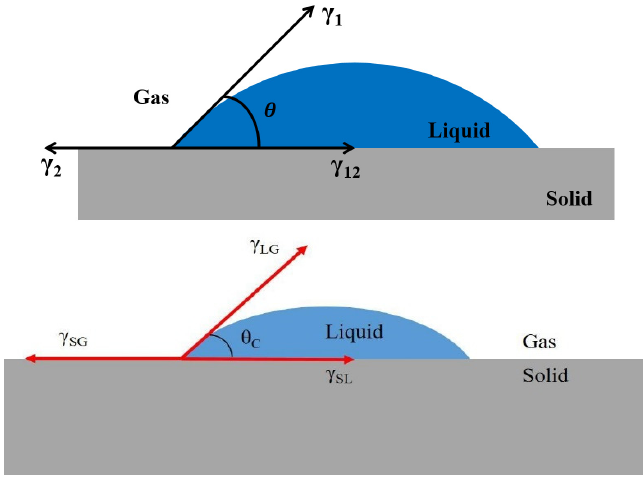
Figure 3. Illustration of contact angle.